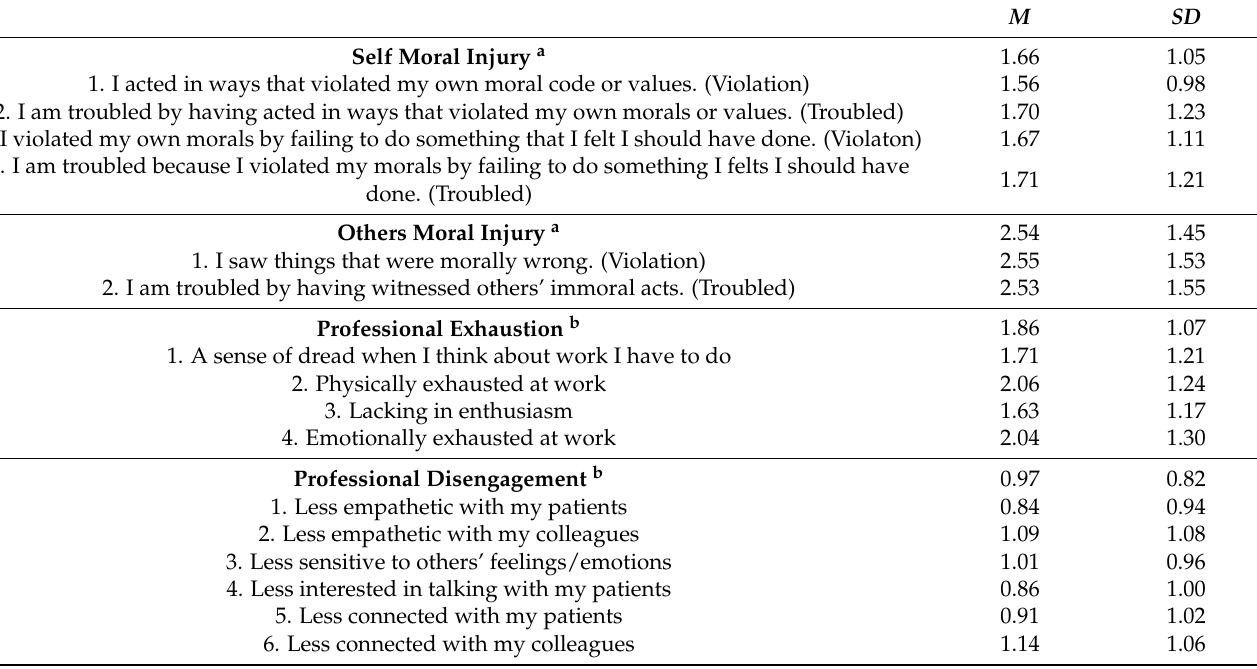
Table 2. Frequency of moral injury and burnout at time 1.